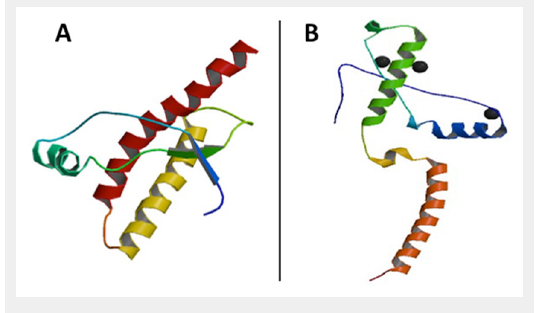
Three dimensional structure of PrP C solved by ( A ) nuclear magnetic resonance (PDB code 1QM1) and ( B ) X-ray diffraction (PDB code